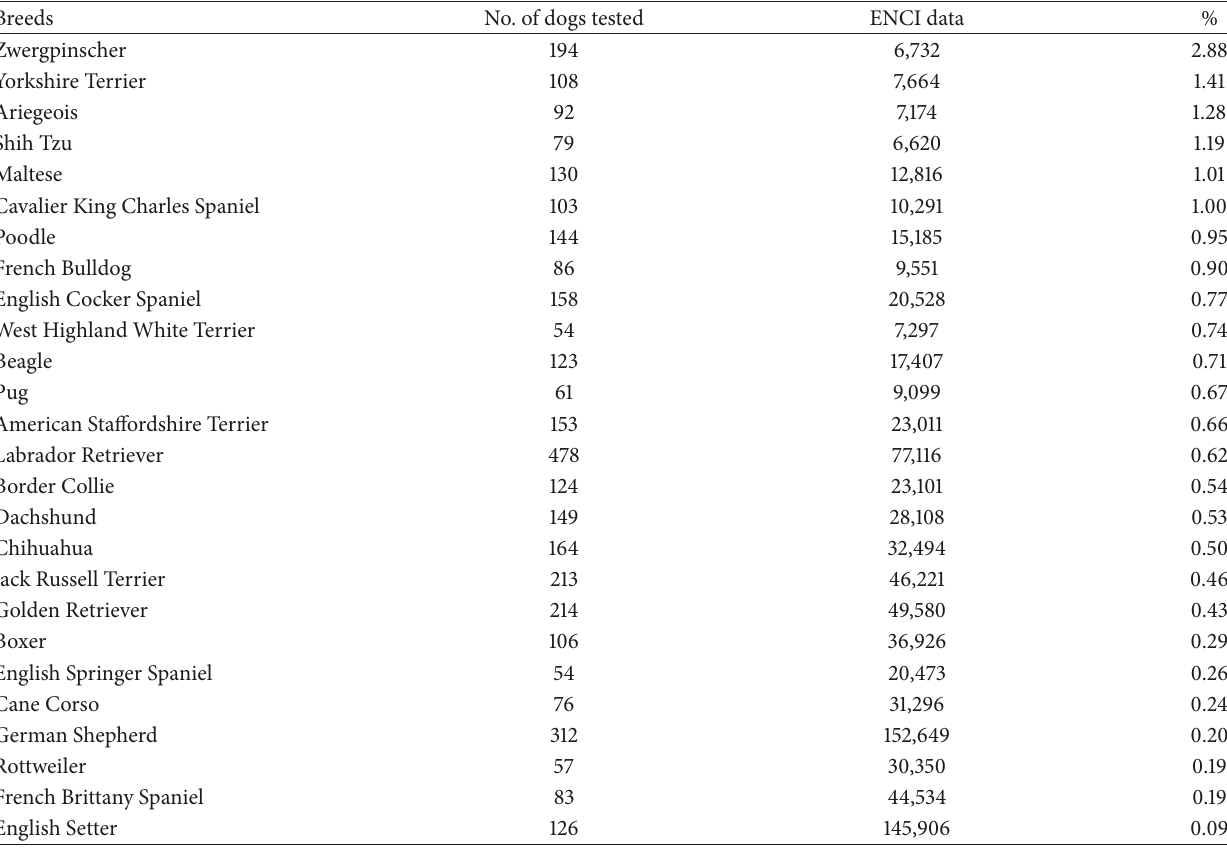
Table 3: Breeds in relation to the overall size of dog breed population according to the ENCI last 10 years of registration. Breeds No. of dogs tested ENCI data % Zwergpinscher 194